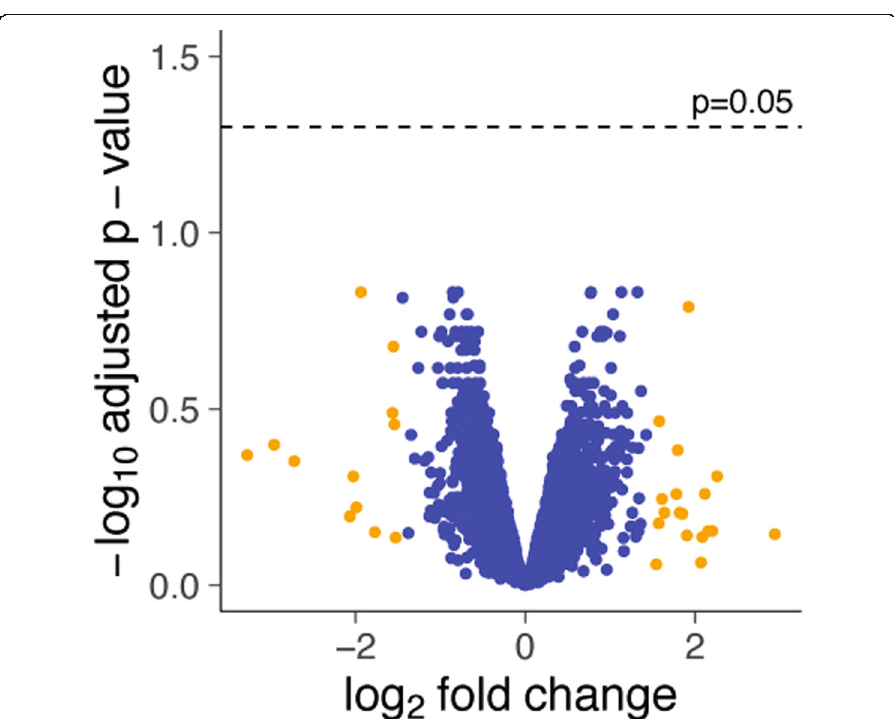
Fig. 2 Volcano plot representing the log-fold change in gene expression with ventilation (comparing male and female mice) against the log of the statistical significance. Only 30 genes (orange dots) had a log-fold change above 1.5, and no gene reached an adjusted p value lower than